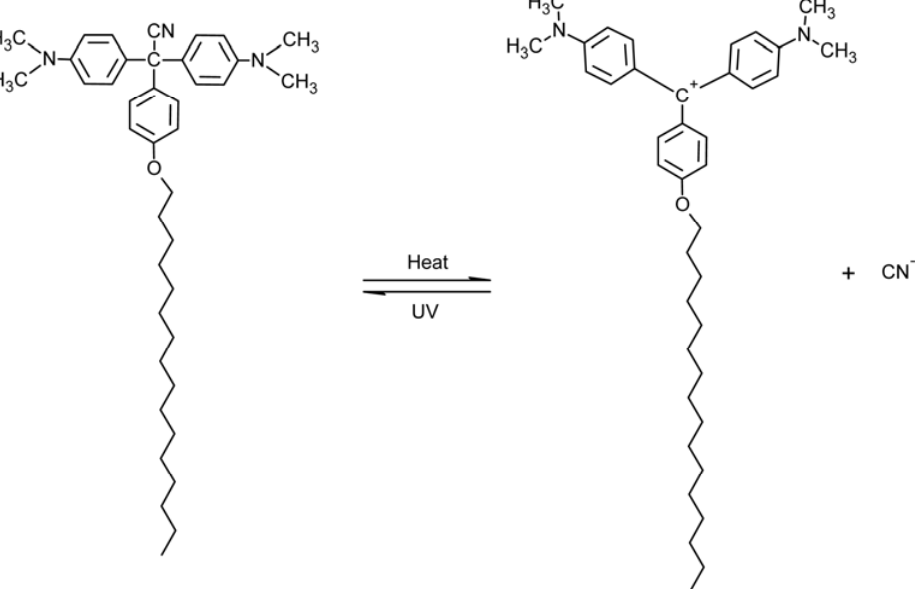
Figure 43. Chemical formula of Malachite Green Leuconitrile derivative.